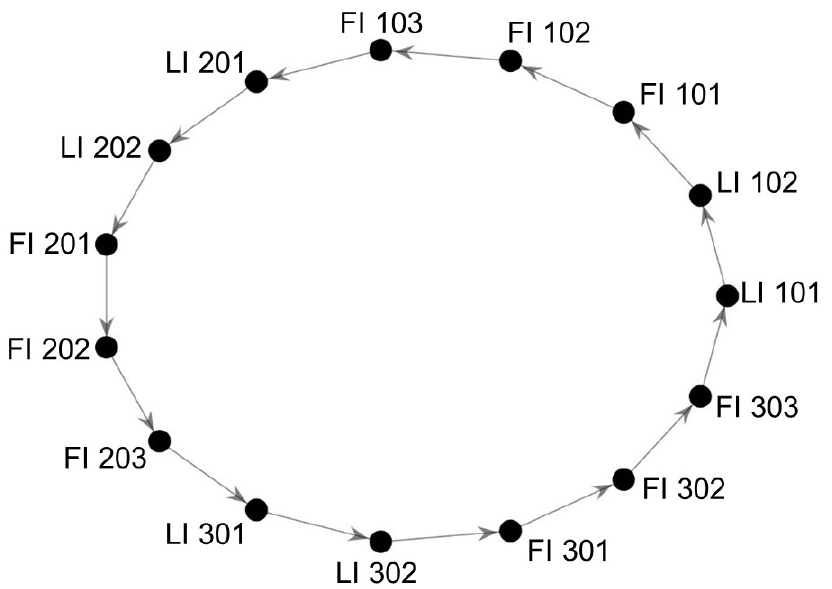
Figure 7. Transitive reduction of the standard causality map to identify the fault in the tank network. The true root cause is a faulty valve online FI 203. The first number in each tag name indicates its PS. LI, level indicator; FI, flow indicator.